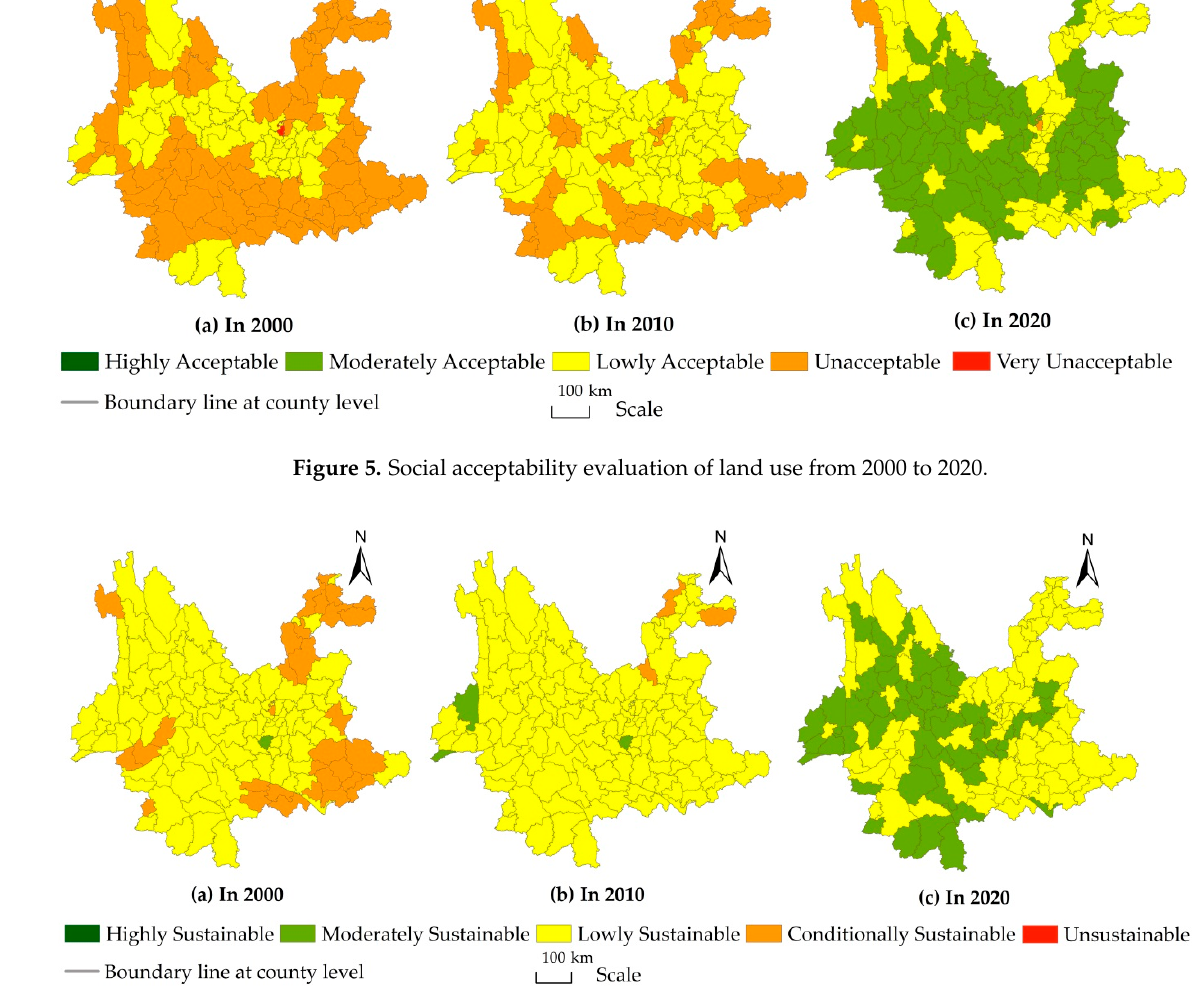
Figure 6. Overall sustainability evaluation of land use from 2000 to 2020.